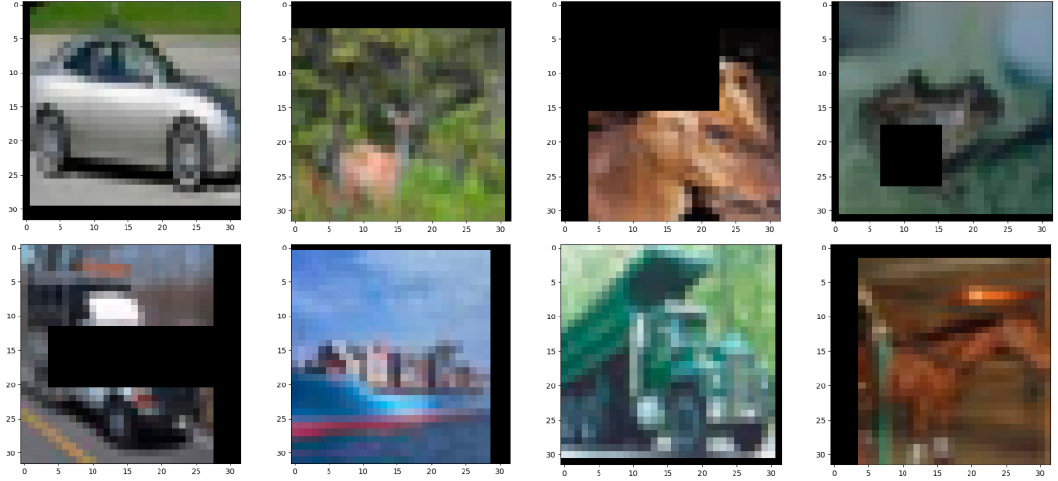
Figure 2. The effect of random erasure algorithm on CIFAR10 dataset.